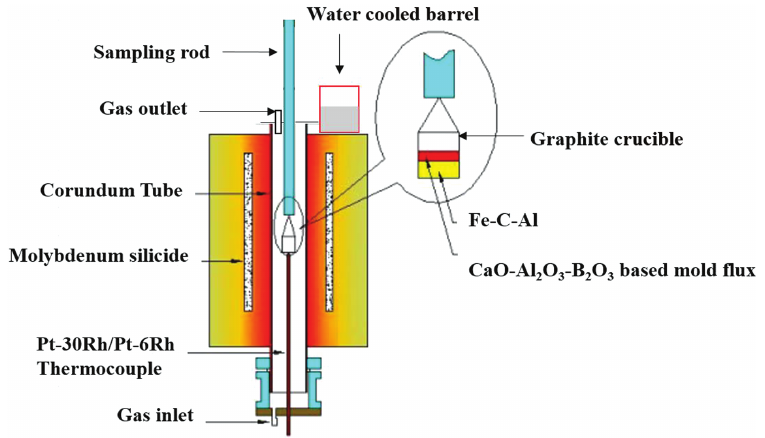
Figure 3: A schematic figure of the experimental